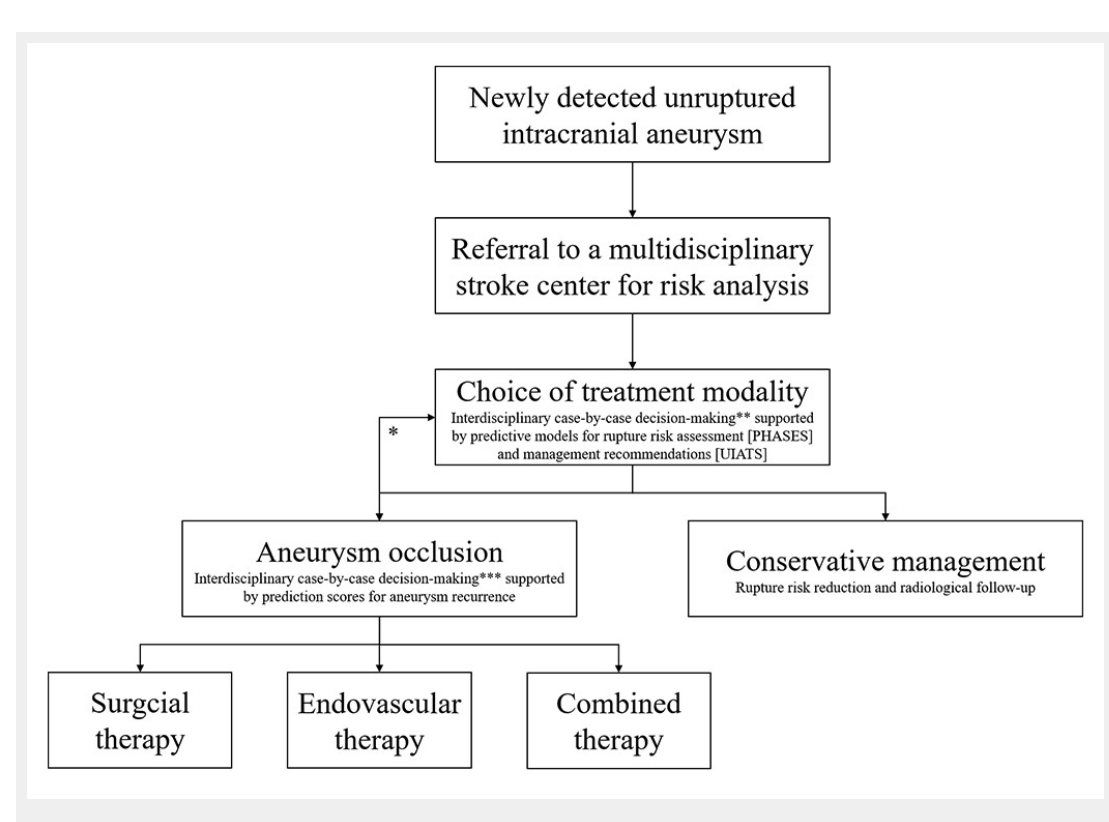
Proposed algorithm for the management of unruptured intracranial aneurysm. * Intervention-related risks may influence treatment indication as such. ** Trade-off between the risk of rupture based on individual patient- and aneurysm-specific risk factors versus the individual treatment risk based on the surgeon’s or interventionalist’s experience, treatment modality, and aneurysm angioarchitecture. *** Trade-off between interventional risk and potential long-term stability based on the patient’s condition, local resources, and aneurysm complexity and